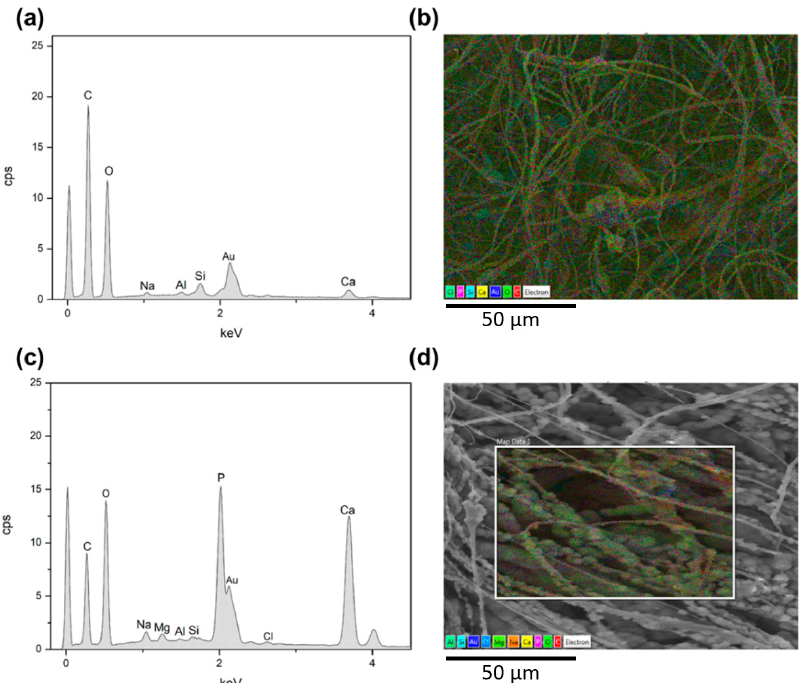
Figure 6. EDS analysis of PLLA-SBA2 samples after 7 days ( a , b ) and 21 days ( c , d ) of soaking in SBF. EDS spectra of PLLA-SBA2 ( a , c ) and comparative EDS layered images ( b , d ) reveal an increment of Ca (yellow) and P (purple) content. SBA2 constituents: Na (orange), Al (green) and Si (cyan). O (bright green) and C (red) mainly relate to PLLA.